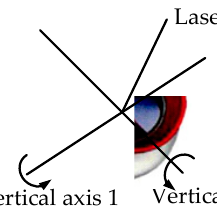
Figure 5. Schematic diagram of laser incident angle error